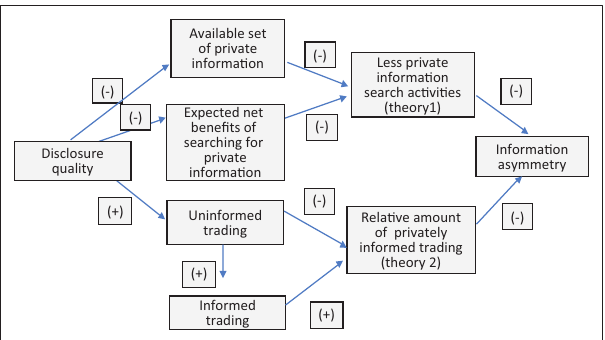
FIGURE 1: The relationship between disclosure, private information search activities, privately informed trading and information